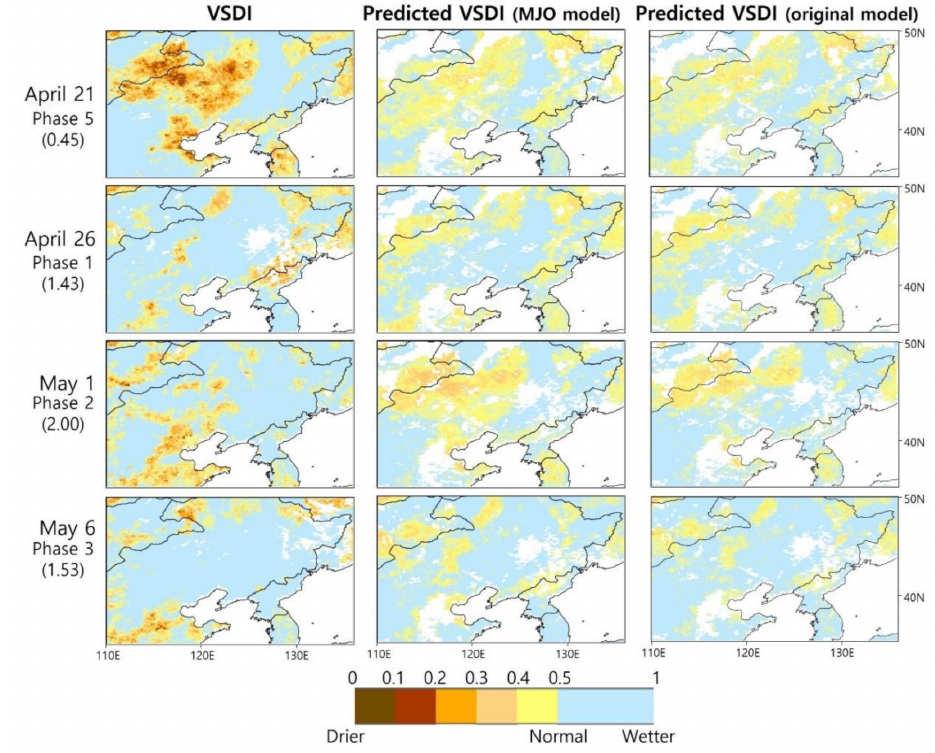
Figure 7. Comparison of temporal change of drought conditions between actual VSDI and predicted VSDIs from two models (with MJO and without MJO) in 2010. MJO phase and amplitude (parenthesis) at each day are indicated on the left. The region corresponds to the dashed rectangles in Figure